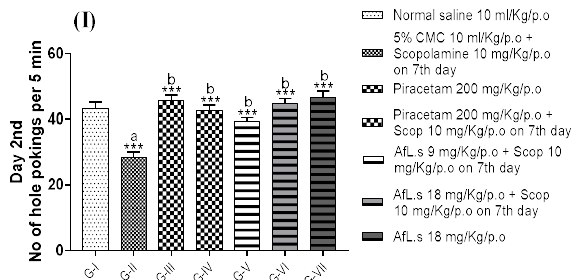
Figure 2. Effect of AfL.s on ( A ) initial transfer latency; ( B ) retention transfer latency; ( C ) inflexion ratio in the elevated plus maze paradigm; ( D ) time spent (sec) in the light compartment on day 1; ( E ) time spent (sec) in the dark compartment on day 1; ( F ) time spent (sec) in the light compartment on day 2; ( G ) time spent (sec) in the dark compartment on day 2; ( H ) number of hole pokings by mice on day 1, and ( I ) number of hole pokings by mice on day 2. Data are presented as mean ± SEM ( n = 6) and one-way ANOVA (Dunnett’s test) was applied by comparing G-II to G-I (presented by “a” on the bar). All other groups were compared to G-II (presented by “b” on the bar). The signs ns, *, ** and *** presented the p values as ≥0.05, ≤0.05, ≤0.01, and ≤0.001, respectively).